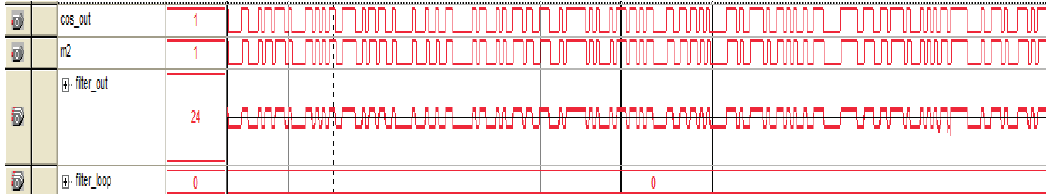
Figure 32. The waveform of the code tracking module.